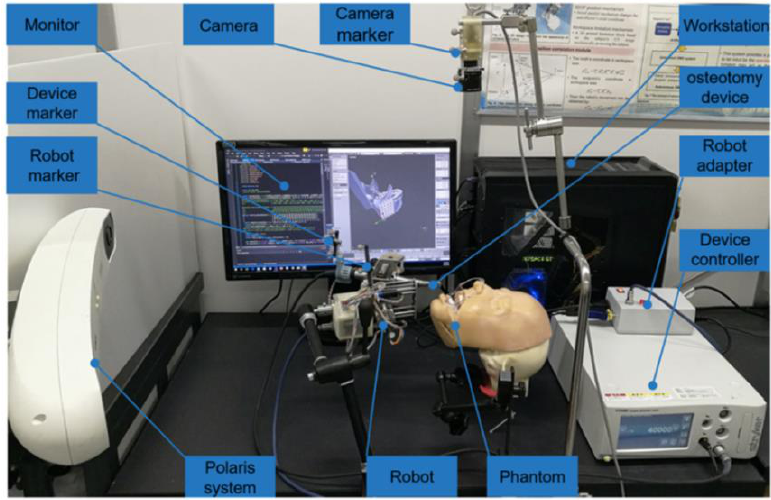
Figure 4 . Overview of the autonomous surgical system for oral and maxillofacial surgery [36] . Figure 4. Overview of the autonomous surgical system for oral and maxillofacial surgery